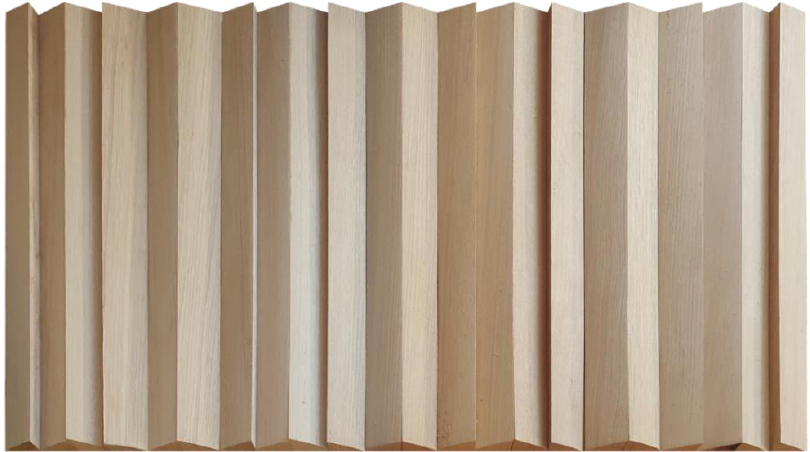
Figure 8. Design of a decorative wooden wall panel from back board residue (© Domagoj Mamić, 2022).